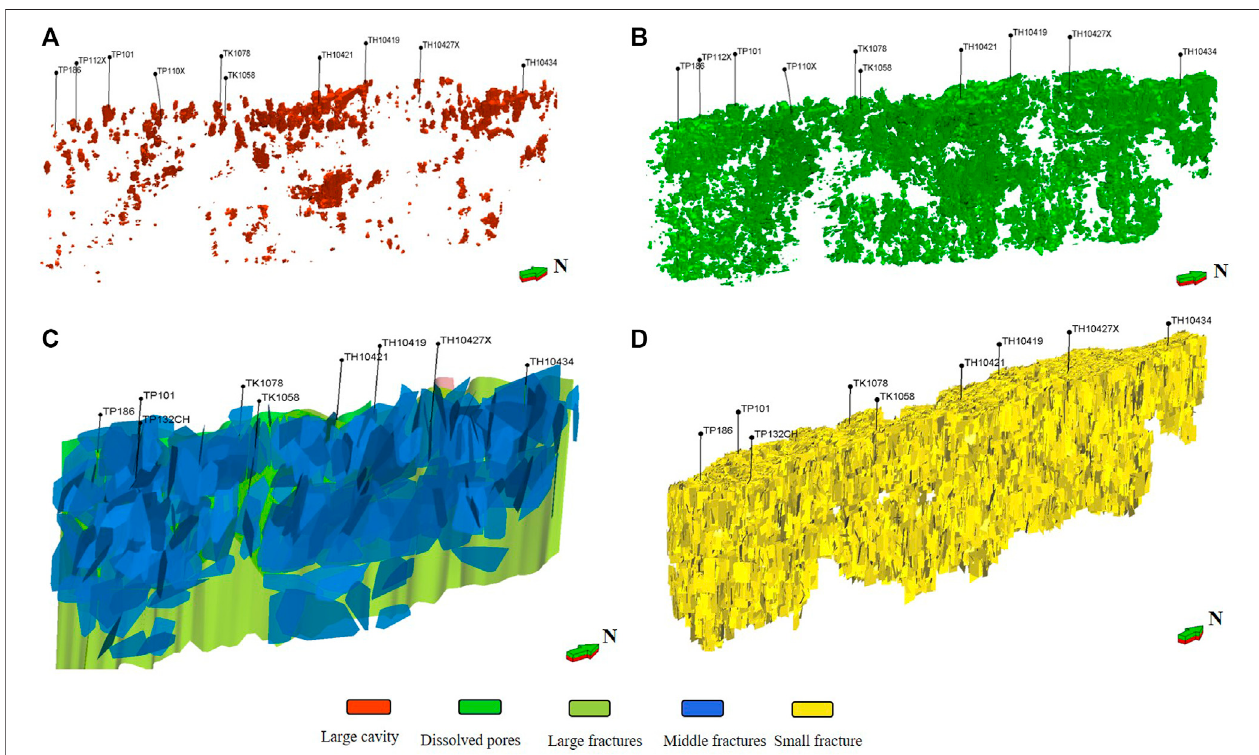
FIGURE8| Fault-controlledpaleokarstinternalelementsmodelsintheTP12CXunits. (A) Three-dimensionalmodeloflargecaves; (B) Three-dimensionalmodelof dissolved pores; (C) Large and medium fracture model; (D) Small fracture model.